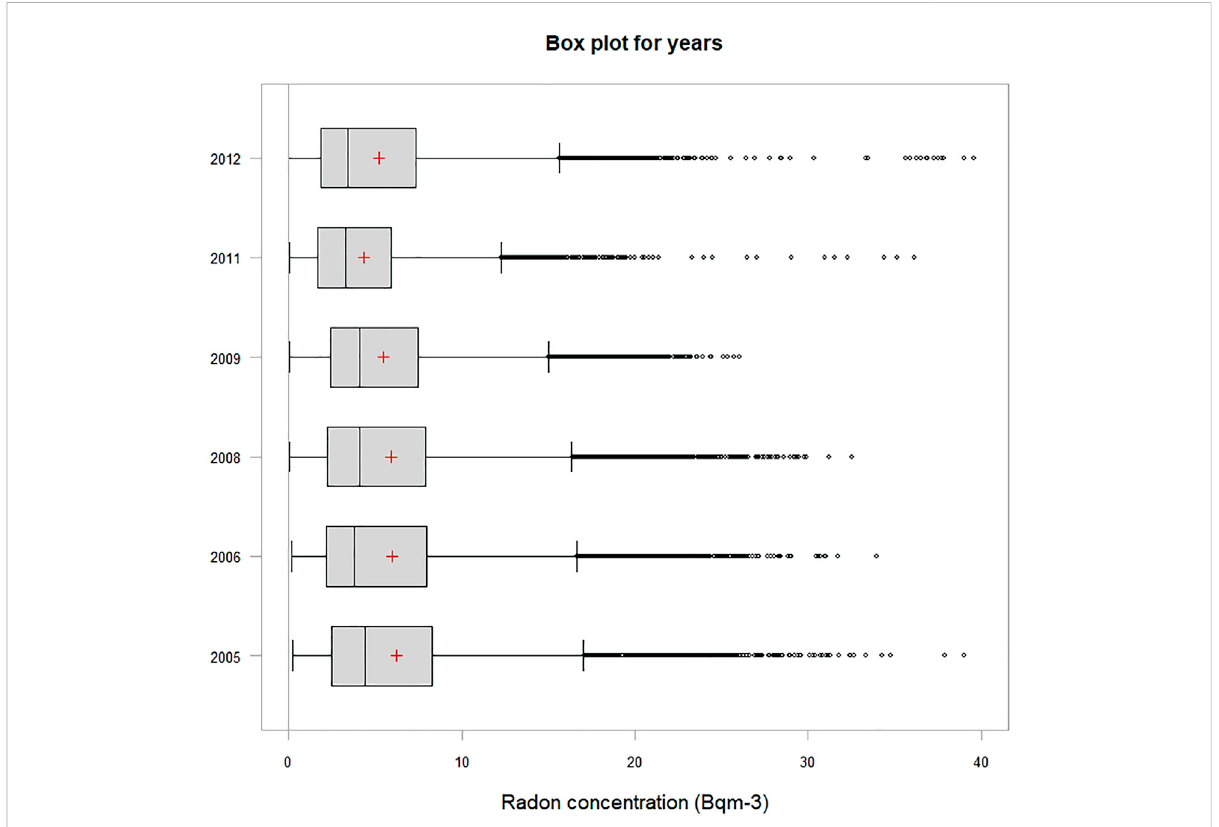
FIGURE 3 Annual averaged box-and-whisker plot of all radon concentration measurements. The left and right box borders represent 25 th and 75 th percentiles, whiskers extends interquartile range by factor 1.5, vertical bar represents the median, red cross, the mean value and black circles, the